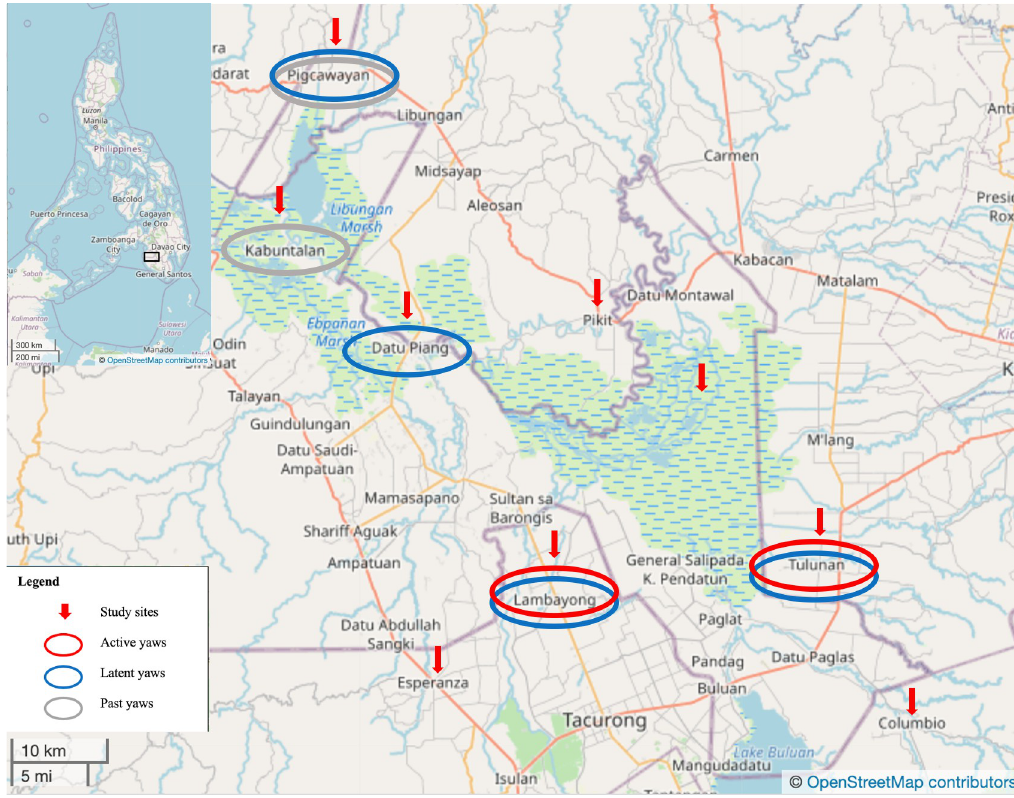
Fig 3. Location map of municipality study sites and yaws cases detected in Mindanao Island, Philippines (Contains information from OpenStreetMap and OpenStreetMap Foundation, which is made available under the Open Database License)